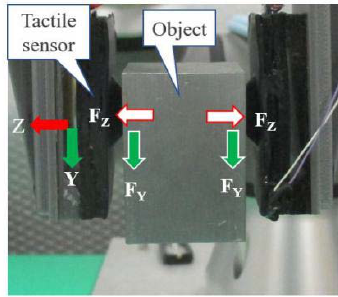
Figure 9. Photograph of the robot hand lifting the object with the Y-axis of the sensor vertical.